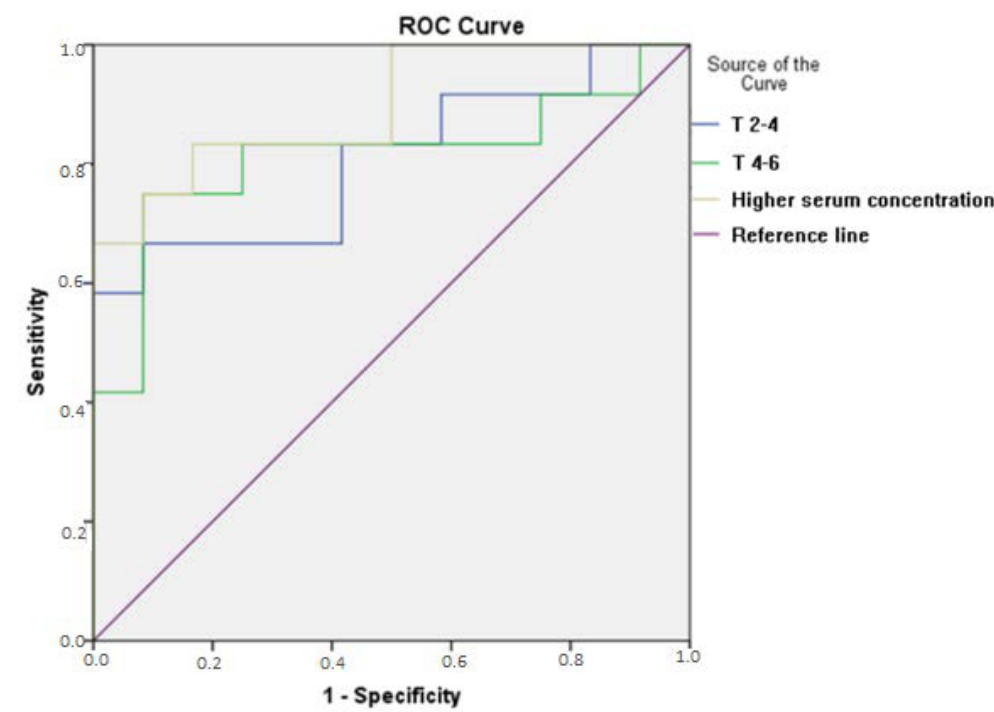
Figure 2. ROC curve for the AKI outcome in the population of septic patients using vancomycin admitted to the ICU. T2-4: Serum concentration between the second and fourth day of use of van- comycin (48–96 h); T4-6: Serum concentration between the fourth and sixth day of use of vancomycin (96–144 h). Based on the values of cutoff obtained by the ROC curve at 2 to 4 days, the free time curve for AKI was constructed. It was observed that in the group with serum concentra- tion >20 mg/L the free time for the development of AKI was lower when compared to the group that had serum concentrations between 17.5 and 20 mg/L, which also presented shorter free time compared to the group with a serum concentration <17.5 mg/L, log-rank <0.001 (Figure 3).